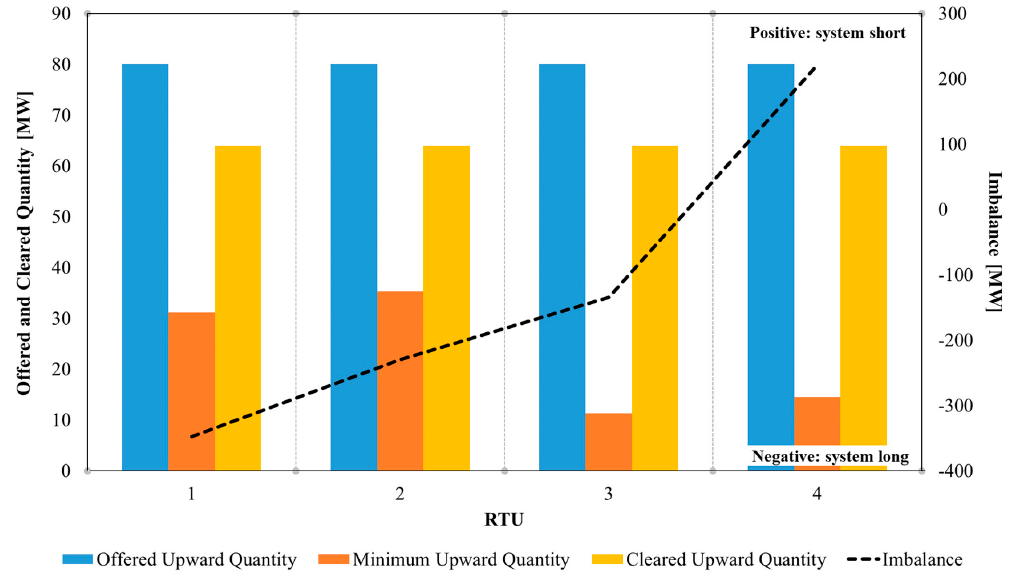
Figure 22. Example of clearing of a linked in time divisible order.